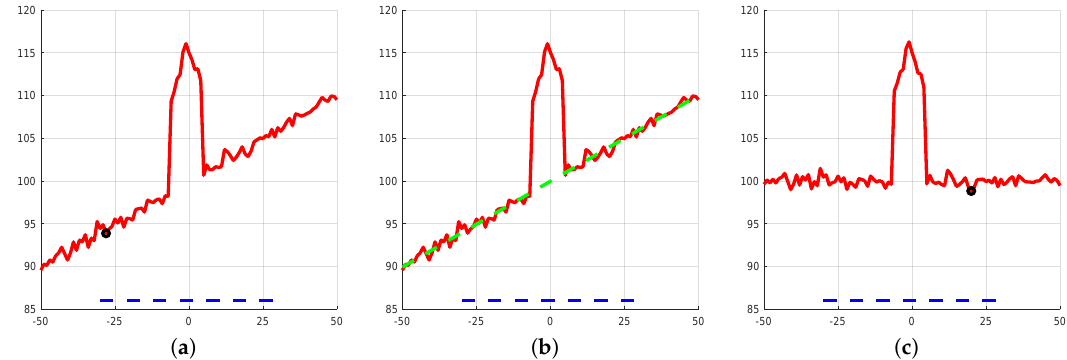
Figure 14. DSM profiles for an artificial building on a tilted surface with added noise: ( a ) Original DSM profile and the minimal height value (black) within the window (blue). ( b ) Robust fit of the surface (green). ( c ) Slope corrected DSM profile and the according minimal height